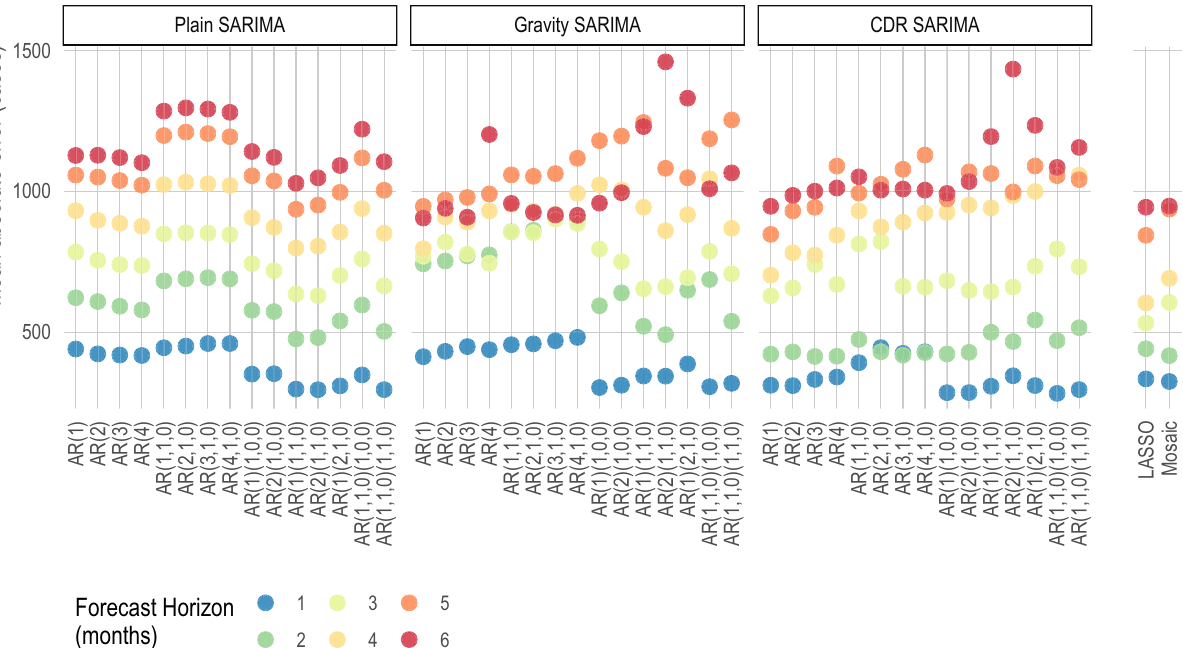
Figure 1. Mean absolute error (MAE) for all Bangkok models. The mean absolute error (y-axis) expressed as number of cases for each model (x-axis) and for each forecast. Models are grouped as SARIMA with no exogenous variables (Plain), SARIMAs with the top 5 most connected regions based on the predicted trips from a gravity model (Gravity SARIMA), and SARIMAs with the top 5 most connected regions based on CDR data (CDR SARIMA). The rightmost models show a data-driven network model, denoted as LASSO, since it is based on a least absolute shrinkage and selection operator prediction model, and mosaic model.